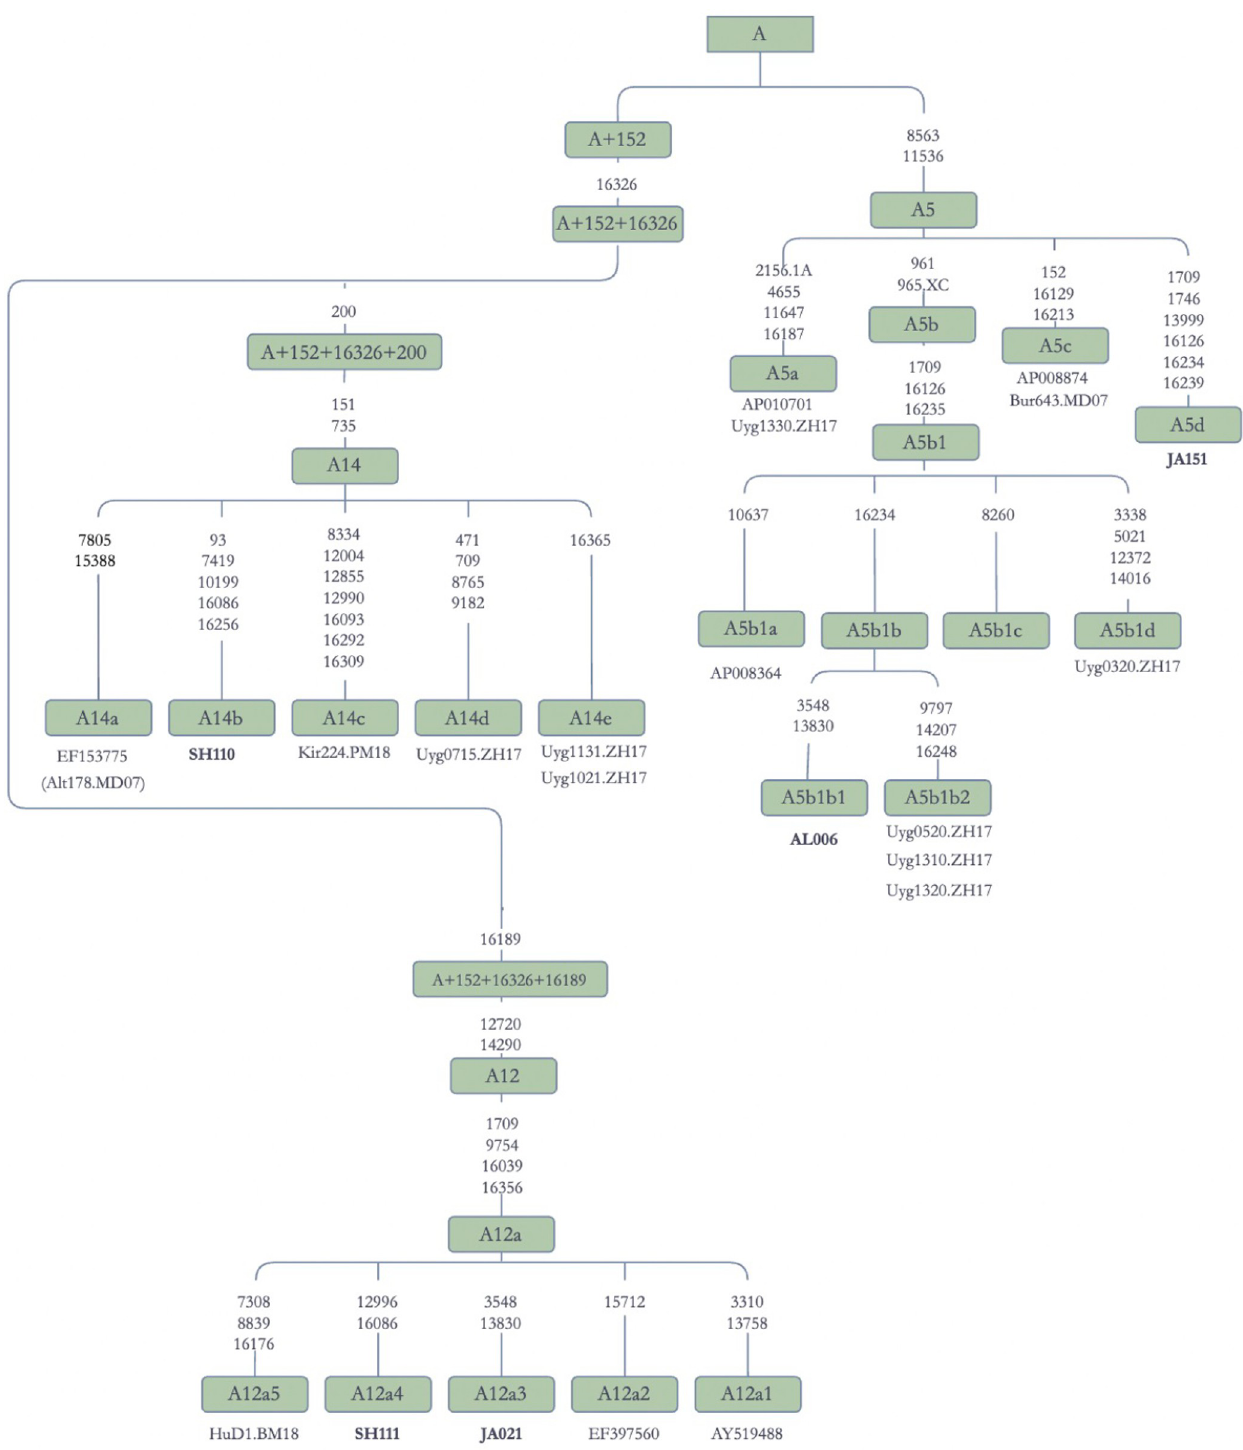
Fig 5. Schematic phylogenetic tree for the haplogroup A mitochondrial genomes. Note: Alt: Altaian; Uyg: Uyghur; Kir: Kirghiz; Hu: Hungarian.